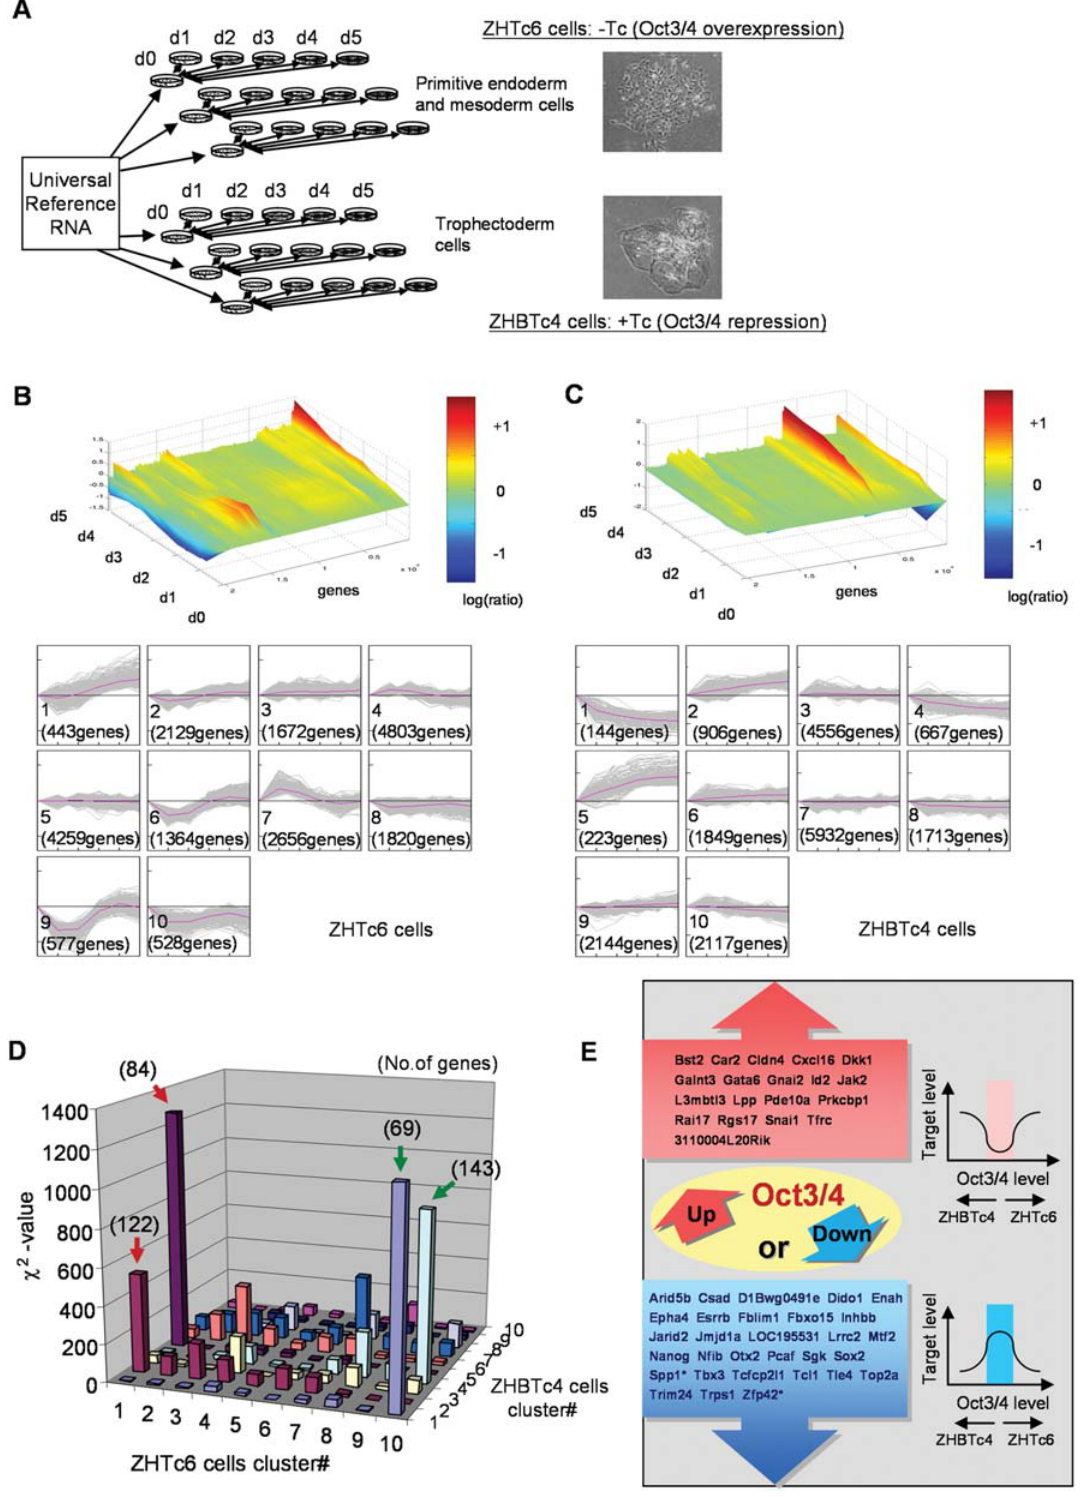
Figure 1. Global gene expression analysis of Oct3/4 manipulated ES cells.(A) Experimental design of microarray analysis. Oct3/4-overexpressing ES cells differentiate to primitive endoderm and mesoderm, whereas Oct3/4-repressed ES cells differentiate towards Trophectoderm. (B)(C) K-means clusters of gene expression levels analyzed by TIGR MEV tool (http://www.tigr.org) and their landscape representations by MATLAB. (D) Comparison of genes grouped in each cluster of ZHTc6 cells and ZHBTc4 cells. The arrows (red and green) show highly correlated clusters between two cell lines (see Materials and Methods). (E) Diagram summarizing the unique mode of gene expression regulation by Oct3/4. Representative Genes identified as the direct downstream targets of Oct3/4 by the ChIP-on-chip assay [33] or ChIP-PET assay [34] are shown. Spp1 and Zfp42 (marked with asterisk) were not detected as a direct downstream target by either ChIP-on-chip or ChIP-PET assays, but have already been shown as such by more direct experimental methods (see the text). doi:10.1371/journal.pone.0000026.g001 PLoS ONE |